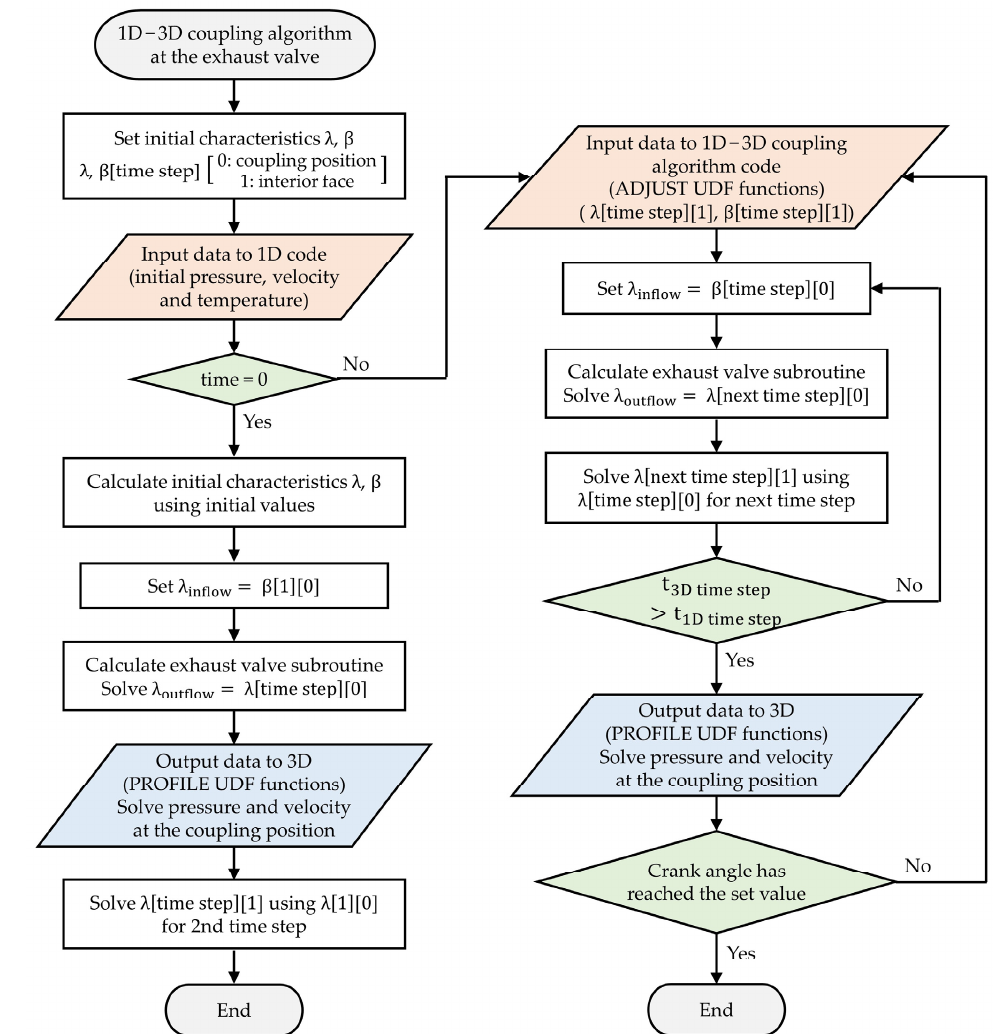
Figure 3. Flow chart of the 1D–3D coupling algorithm in the exhaust valve boundary